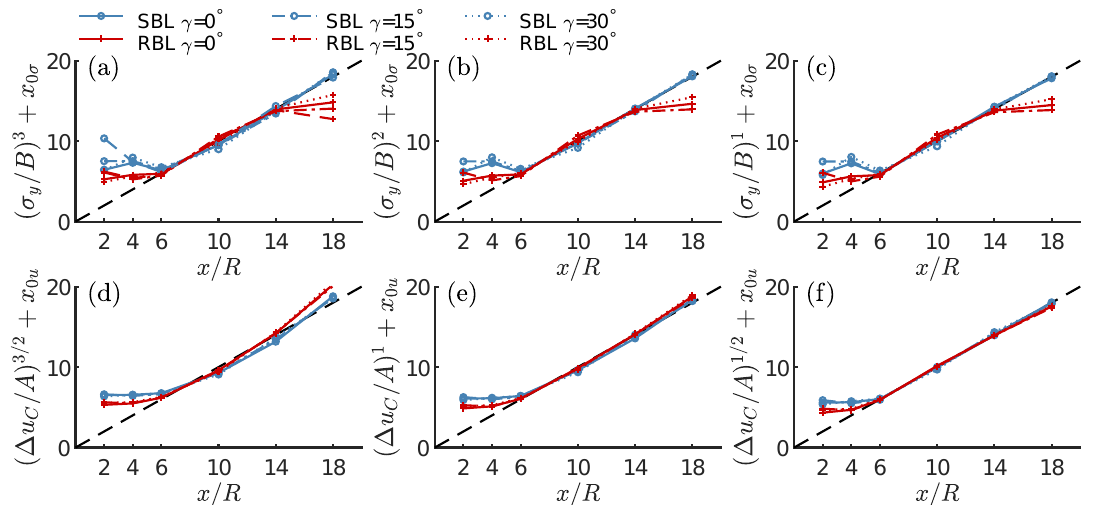
Figure 10. Normalised lateral wake width σ y and normalised centreline velocity deficit ∆ u C as function of x / R for ( a )/( d ) the equilibrium scaling ∆ u 3/2 , σ 3 y ∝ x ; for ( b )/( e ) the square-root wake growth C scaling ∆ u C , σ 2 y ∝ x ; for ( c )/( f ) the linear wake growth scaling ∆ u 1/2 , σ y ∝ x . Fits include the range C 6 ≤ x / R ≤ 18 for SBL and 6 ≤ x / R ≤ 14 for RBL. The legend indicates the flow